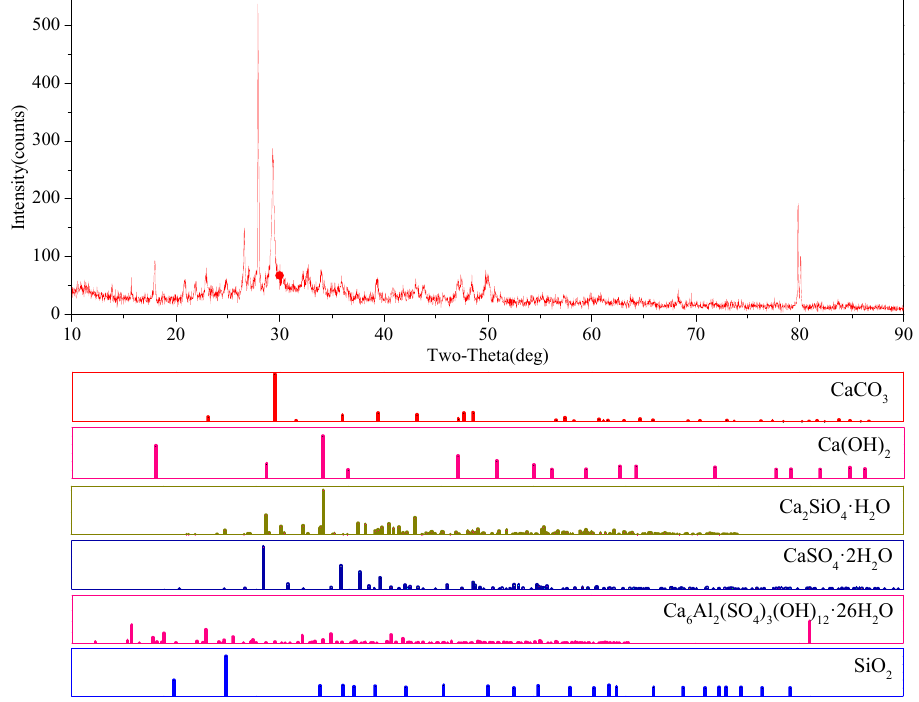
Figure 8. Diffraction pattern and main phase of paste backfill specimen submerged in a 15 g/L sulfate solution for 40 days.